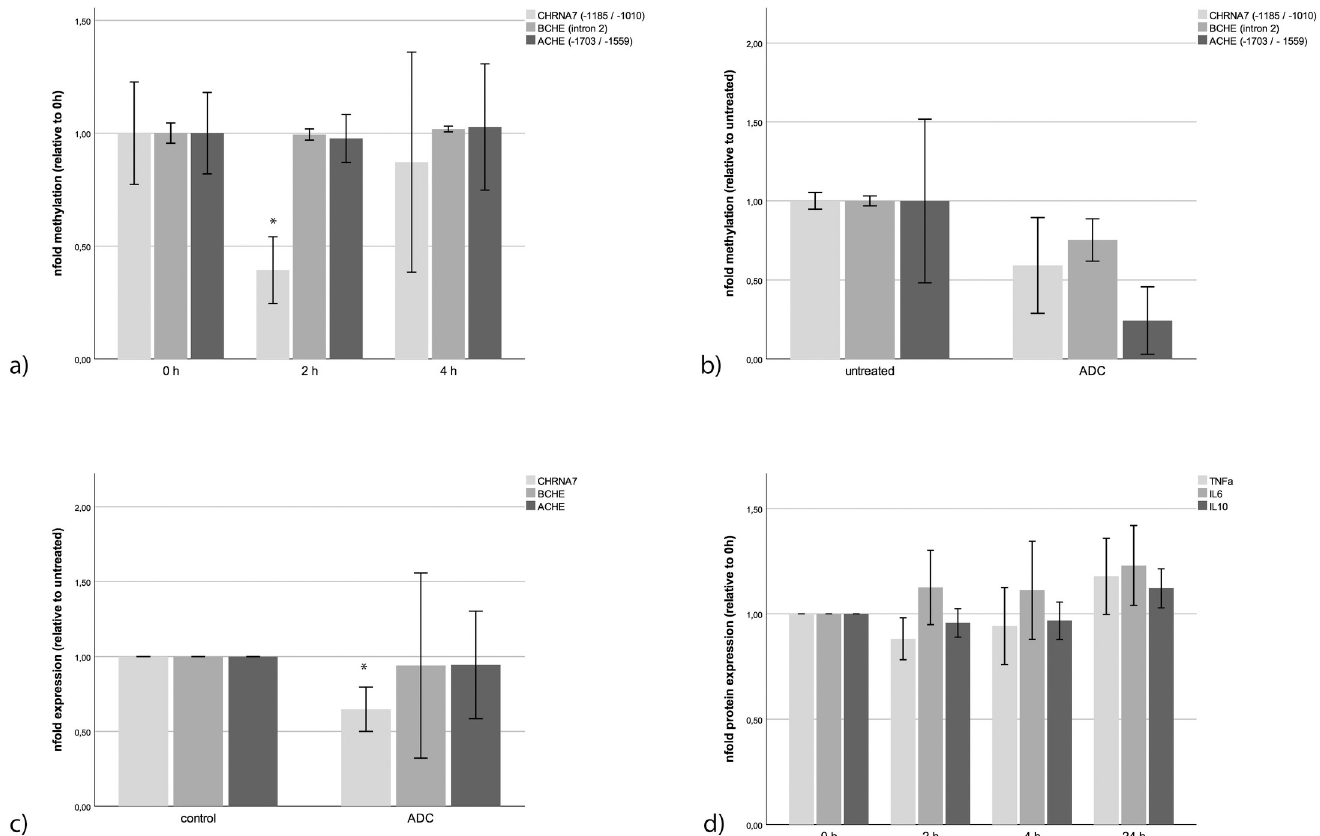
Fig 1. Methylation of cholinergic genes in neuronal SH-SY5Y cells after stimulation (n = 3). ( a ) We could not detect any significantly modified methylation in the promoter of the ACHE gene (area -1703/-1559) and BCHE gene (intron 2), apart from a decreased methylation in the promoter of the CHRNA7 gene (area -1185/- 1010; p = 0.011) after stimulating SH-SY5Y cells with 25 μ g/ml propofol for 2 h. Methylation of CHRNA7 recovered after 4h to almost unstimulated levels. ( b ) The artificial de-methylation of the epigenome of SH-SY5Y cells using 5-aza-2’ deoxycytidine (ADC, 50 μ M) resulted in a visible decrease of overall methylation as measured in the three promoter regions. ( c ) This de-methylation reduced the expression of CHRNA7 mRNA (p = 0.034) but did not affect ACHE or BCHE significantly. ( d ) Propofol did not change the expression of proinflammatory (TNF α and IL-6) and anti-inflammatory cytokines (IL-10). Error bars depict 2 x SE.